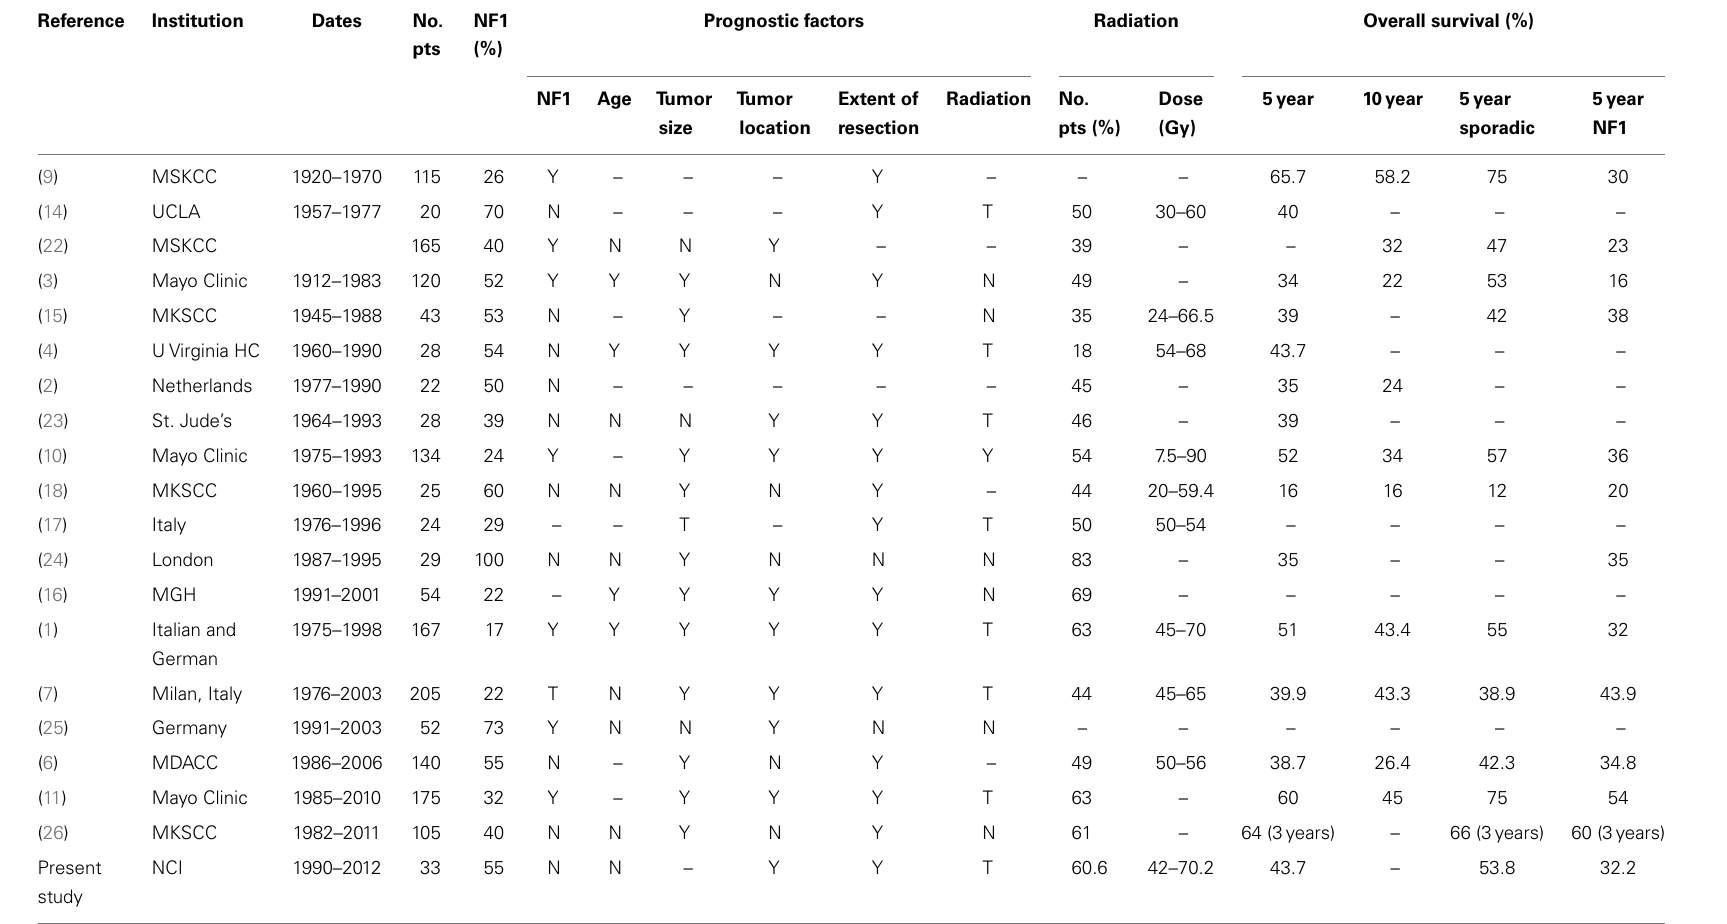
Table 4 | Previous studies on treatment of MPNSTs